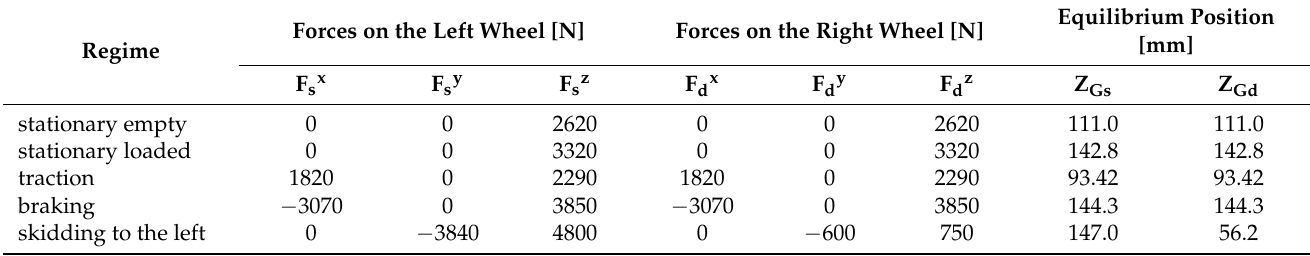
Table 2. The equilibrium position of the wheel suspension system.